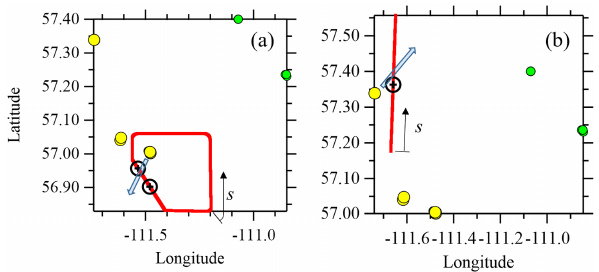
Figure 2. Example horizontal flight path of a box flight (a) and a screen flight (b) . Flight paths for the box and screen portion of the flight shown as red lines. Stack locations are shown as filled yellow circles (SO 2 emitting) and green circles (non-SO 2 emitting). The blue arrow shows the forward trajectory of the plume using the aver- age wind direction during each flight segment. The plume locations determined by observations (Fig. 3) are shown as black cross-hairs on the flight paths. The location of the flight path coordinate s origin is labelled in each